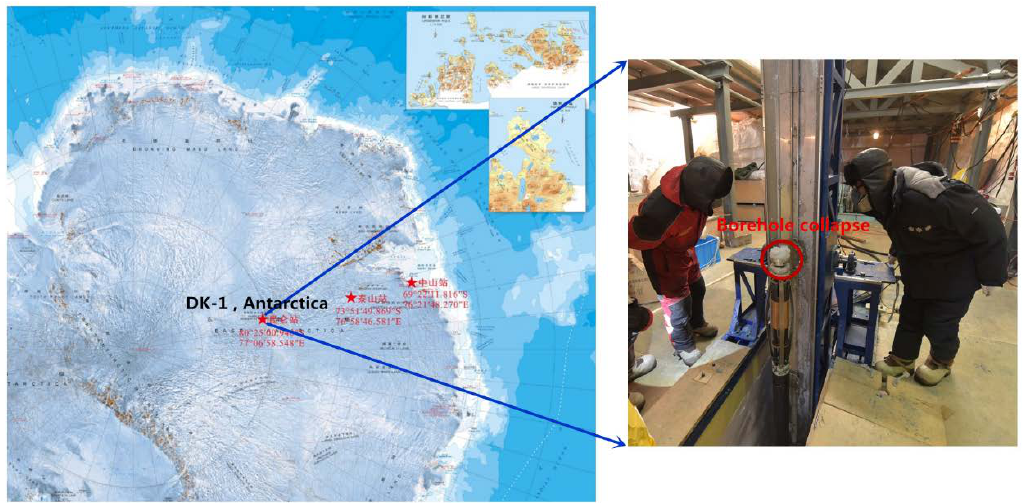
Figure 1. Location of the Chinese first deep ice-core drilling project DK-1 at Dome A, Antarctica, and the phenomenon of borehole collapse.